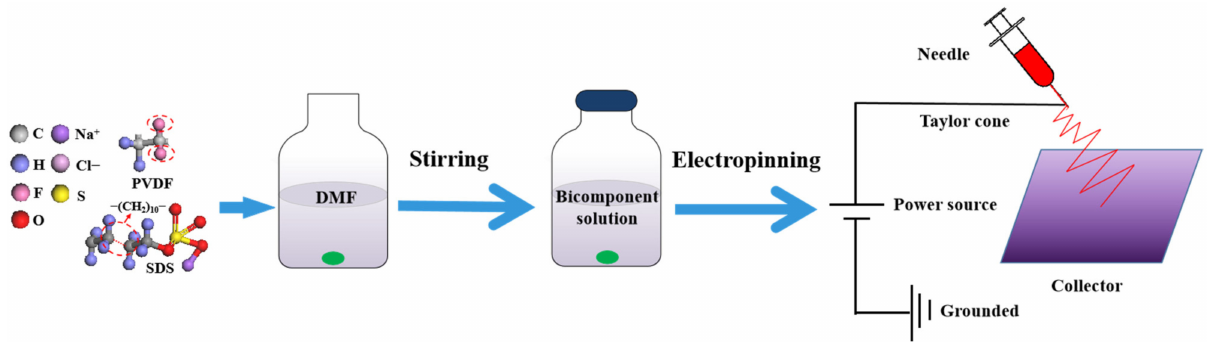
Figure 1. Schematic representation of experimental process.